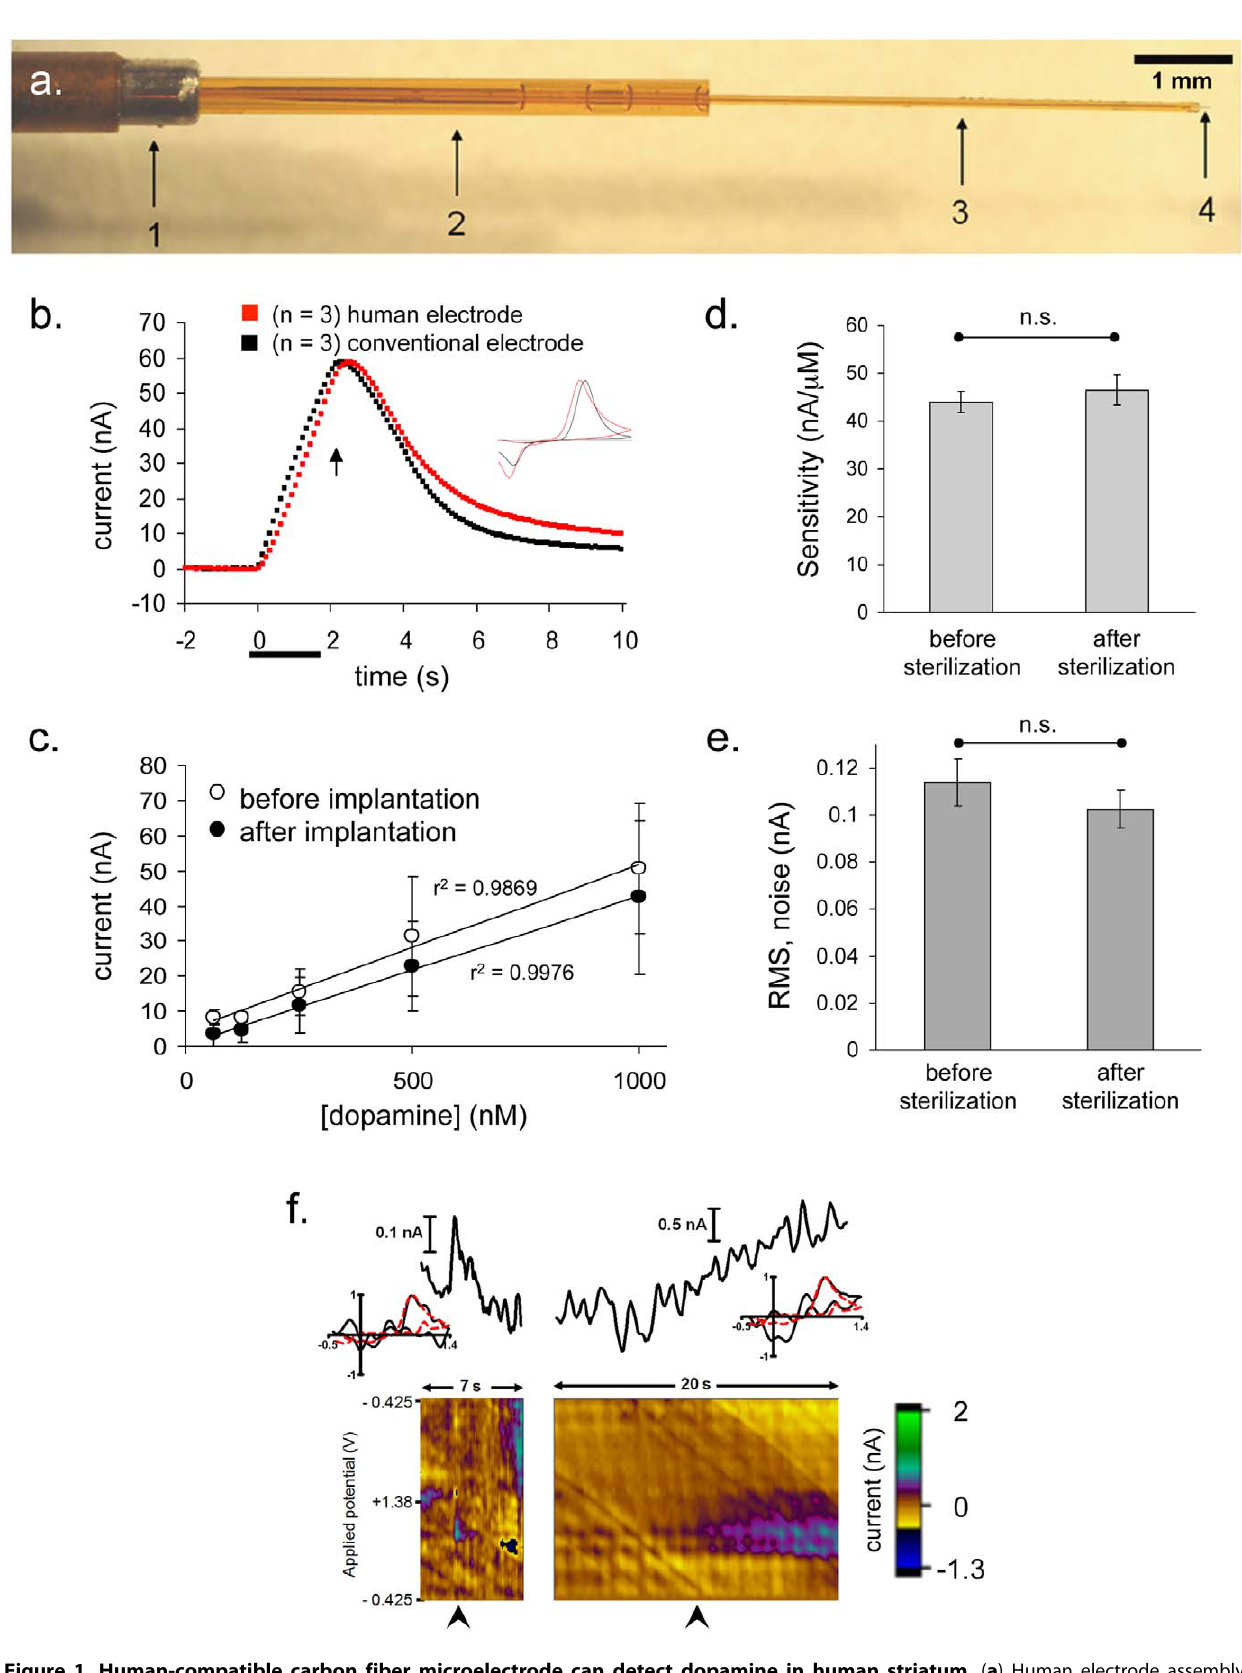
Figure 1. Human-compatible carbon fiber microelectrode can detect dopamine in human striatum. ( a ) Human electrode assembly comprised of protective tube with reference electrode at the tip (1), large-gauge fused silica capillary (2), small-gauge fused silica (3) and carbon fiber (4). ( b ) Average change in peak oxidative current in rat striatum following electrical stimulation (60 Hz, 120 pulses, 300 m A) of dopamine axon